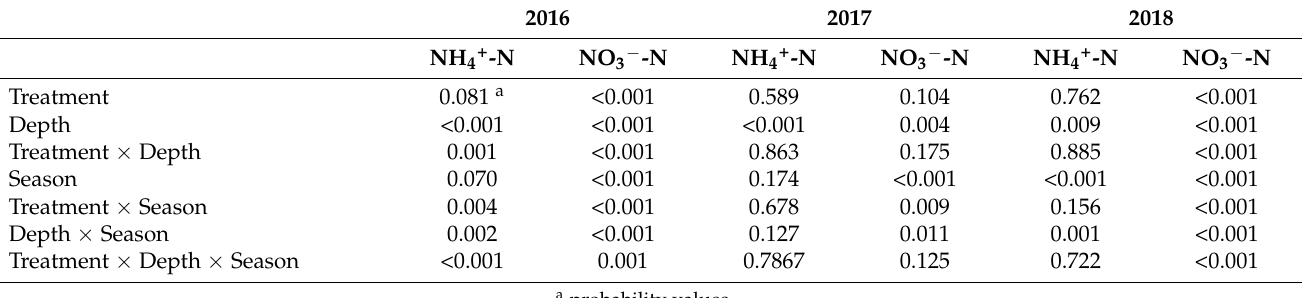
Table 3. Results of ANOVA for the concentrations of ammonium nitrogen (NH 4+ -N, mg kg –1 ) and nitrate nitrogen (NO 3 − -N, mg kg –1 ) with annual applications of combination of nitrogen fertilizer and nitrification inhibitors (2-chloro-6-(trichloromethyl)-pyridine (Nitra-pyrin), di-cycandiamide (DCD)) in soils collected during the growing season (spring, summer, fall) at different depths (sawdust layer, 0–15 cm, 15–30 cm and 30–60 cm) in 2016, 2017 and 2018 in a long-term blueberry experiment (N = 396).